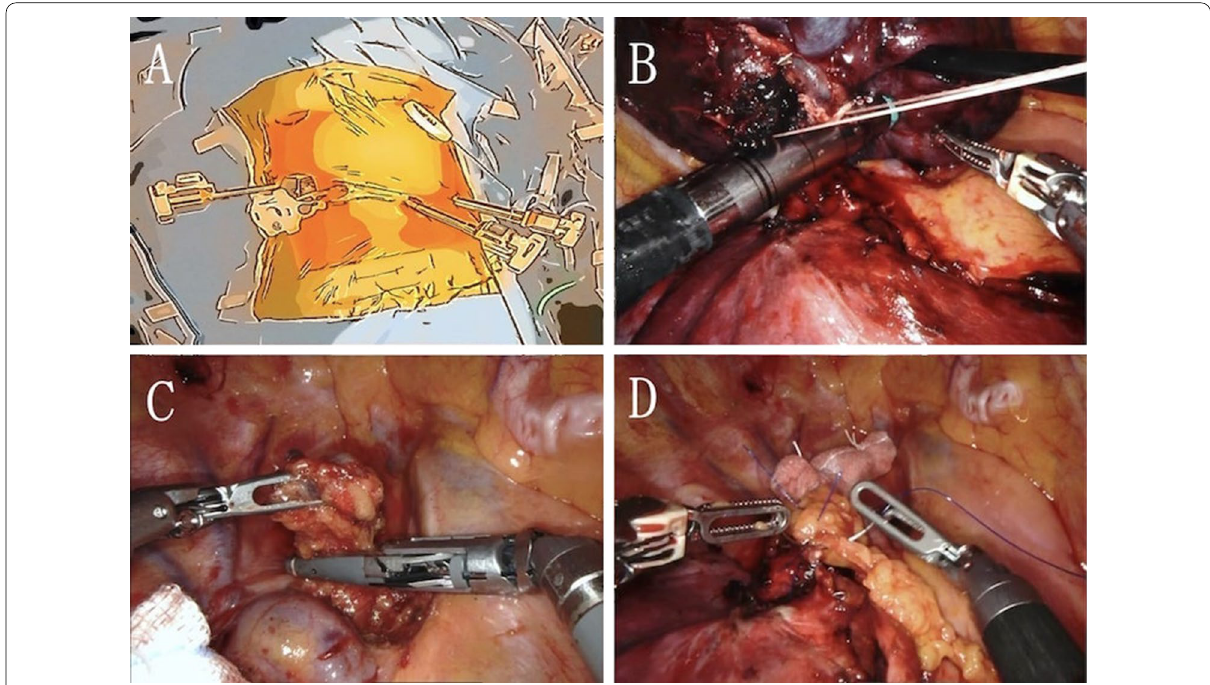
Fig. 3 A Four-port incisions and a CO 2 insufflation combined assistant port before docking the robot. The patient’s head is at the top of the picture. B Robot-assisted thoracoscopic right upper lobectomy followed by lymph node dissection is performed. C Upper mediastinum (station #4R) dissection. D Bronchial stump covered by a pericardial fat